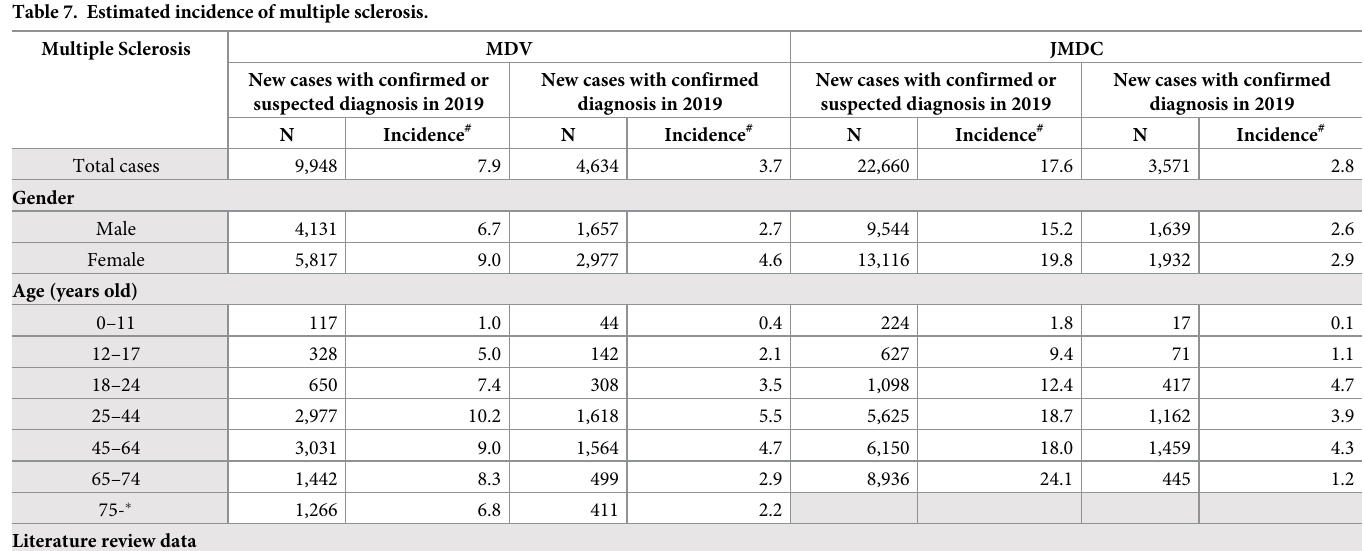
Table 7. Estimated incidence of multiple sclerosis.